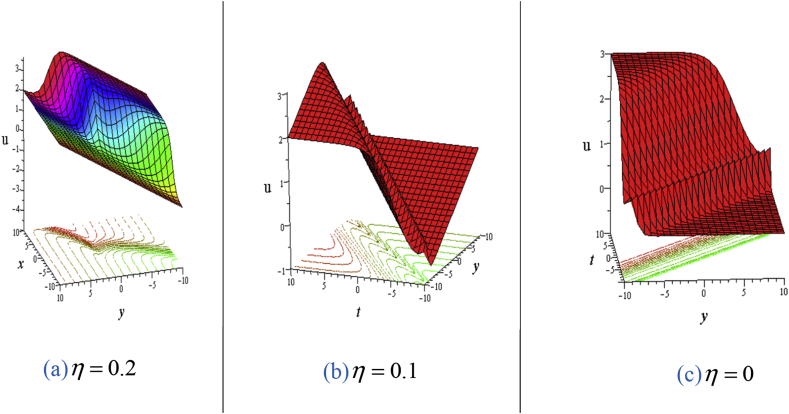
Profile of the Eq. (10) for ℓ1=ℓ5=0,ℓ3=ℓ4=ℓ7=ℓ8=ℓ9=ℓ12=h1=σ=1,δ=:2: 3D plot (upper) and corresponding contour plot (below) at t=0 where images (a) for η=0.2, (b) for η=0.1 and (c) for η=0.